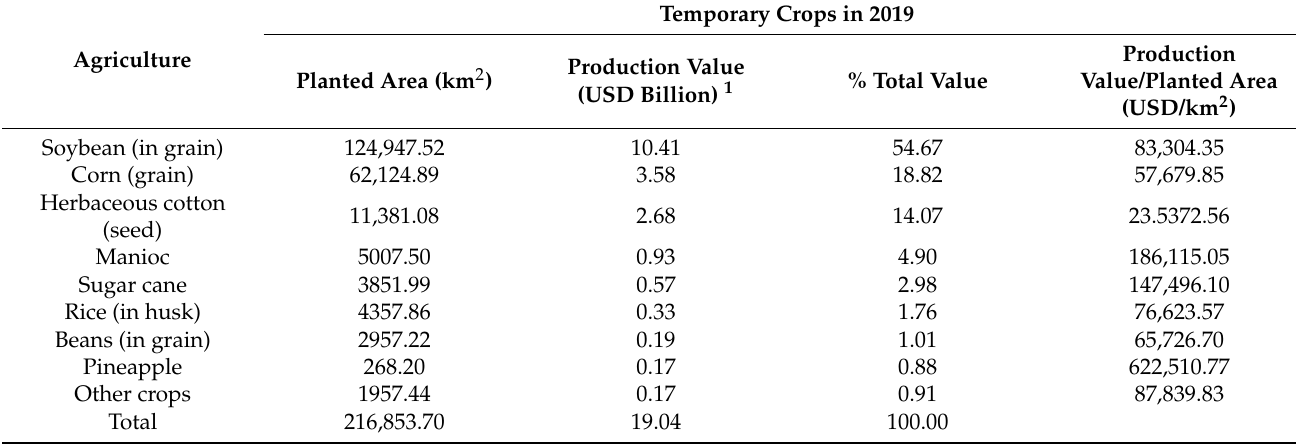
Table 4. Planted area (km 2 ) and production value (USD billion) of temporary crops in the Brazilian Amazon in 2019. Source: